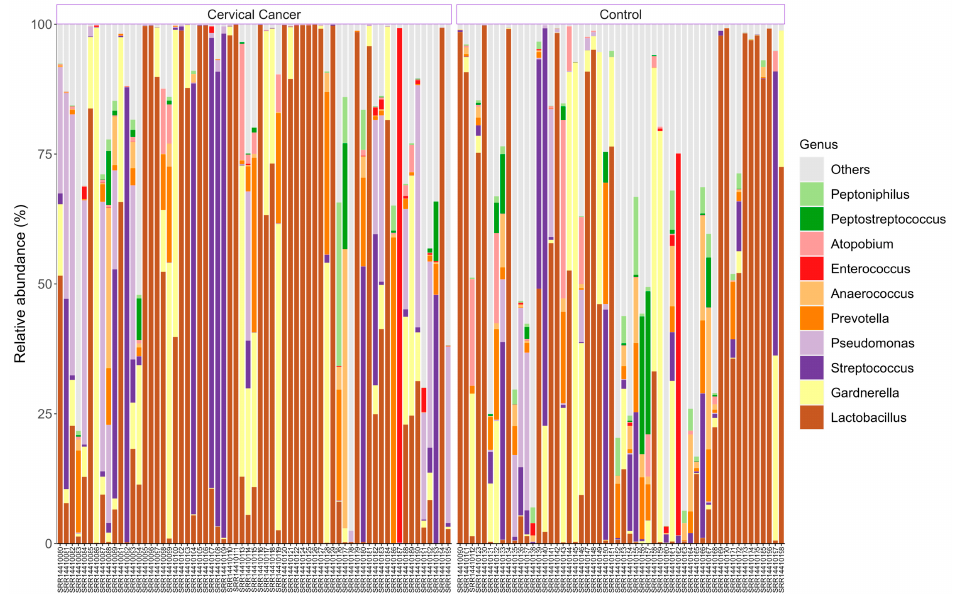
Figure 2. Boxplot illustrating the relatively abundant microbiome of diseased and control groups at the class level. The cervical cancer group is shown in green color, and the healthy control group is shown in orange color.